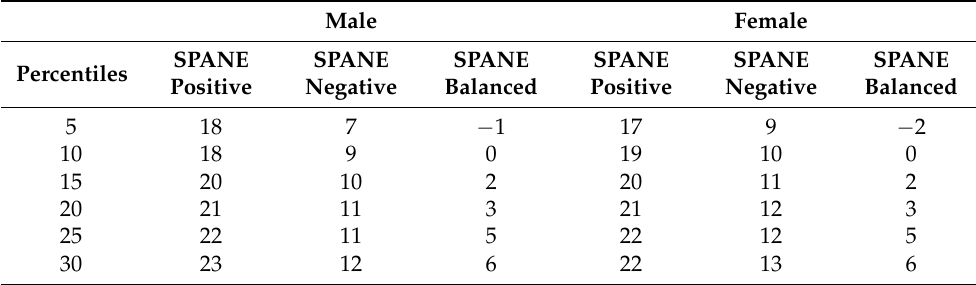
Table 4. Percentiles for the Scale of Positive and Negative Experience (SPANE), and for